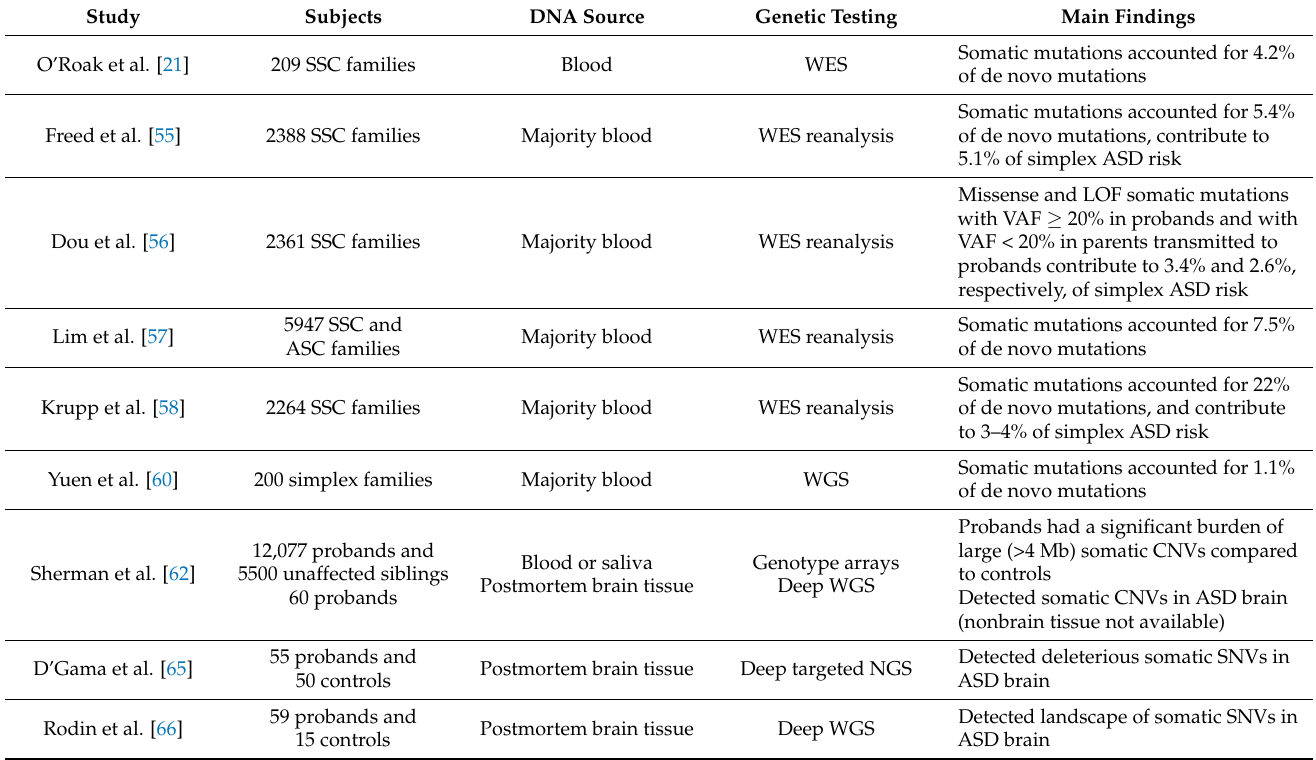
Table 1. Summary of studies analyzing NGS data for somatic mosaicism in